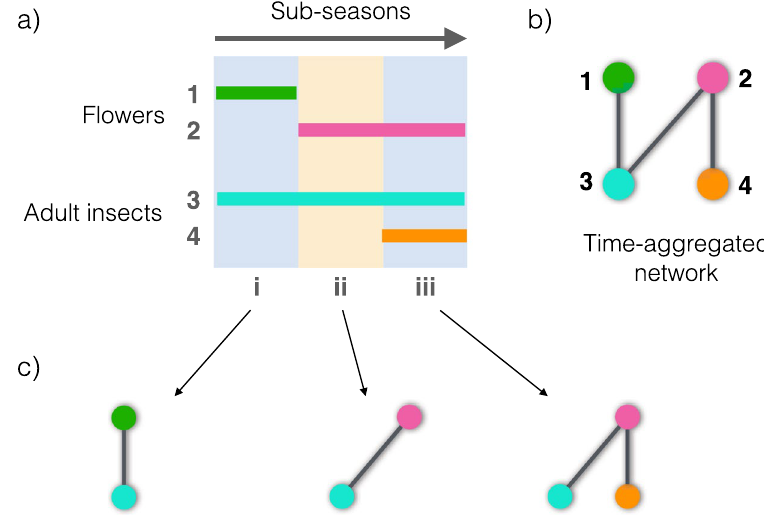
Figure 1. Graphical representation of the within-year temporal dynamics of networks driven by species phenologies. ( a ) Flowering phenology (species 1 and 2) and pollinator activity (species 3 and 4) of a hypothetical plant–pollinator web. Horizontal bars represent phenophases (activity periods) of each species throughout three consecutive sub-seasons (i, ii and iii). ( b ) Bipartite graph corresponding to the plant– pollinator network resulting from ( a ), aggregated through all sub-seasons, as done in most studies. ( c ) Sequence of three snapshots corresponding to the structure of the web in each sub-season. Note that the structure of the time-aggregated network ( b ) is never realized at any given time, resulting in a picture quite different from the static view of network topology. Also, the interactions between plants and pollinators are not necessarily transitive. This means that, if an interaction is active in later sub-seasons (e.g. the one between species 2 and 4 occurring in sub-season iii), it cannot propagate effects to others occurring in the past (e.g. between species 3 and 1 in sub-season